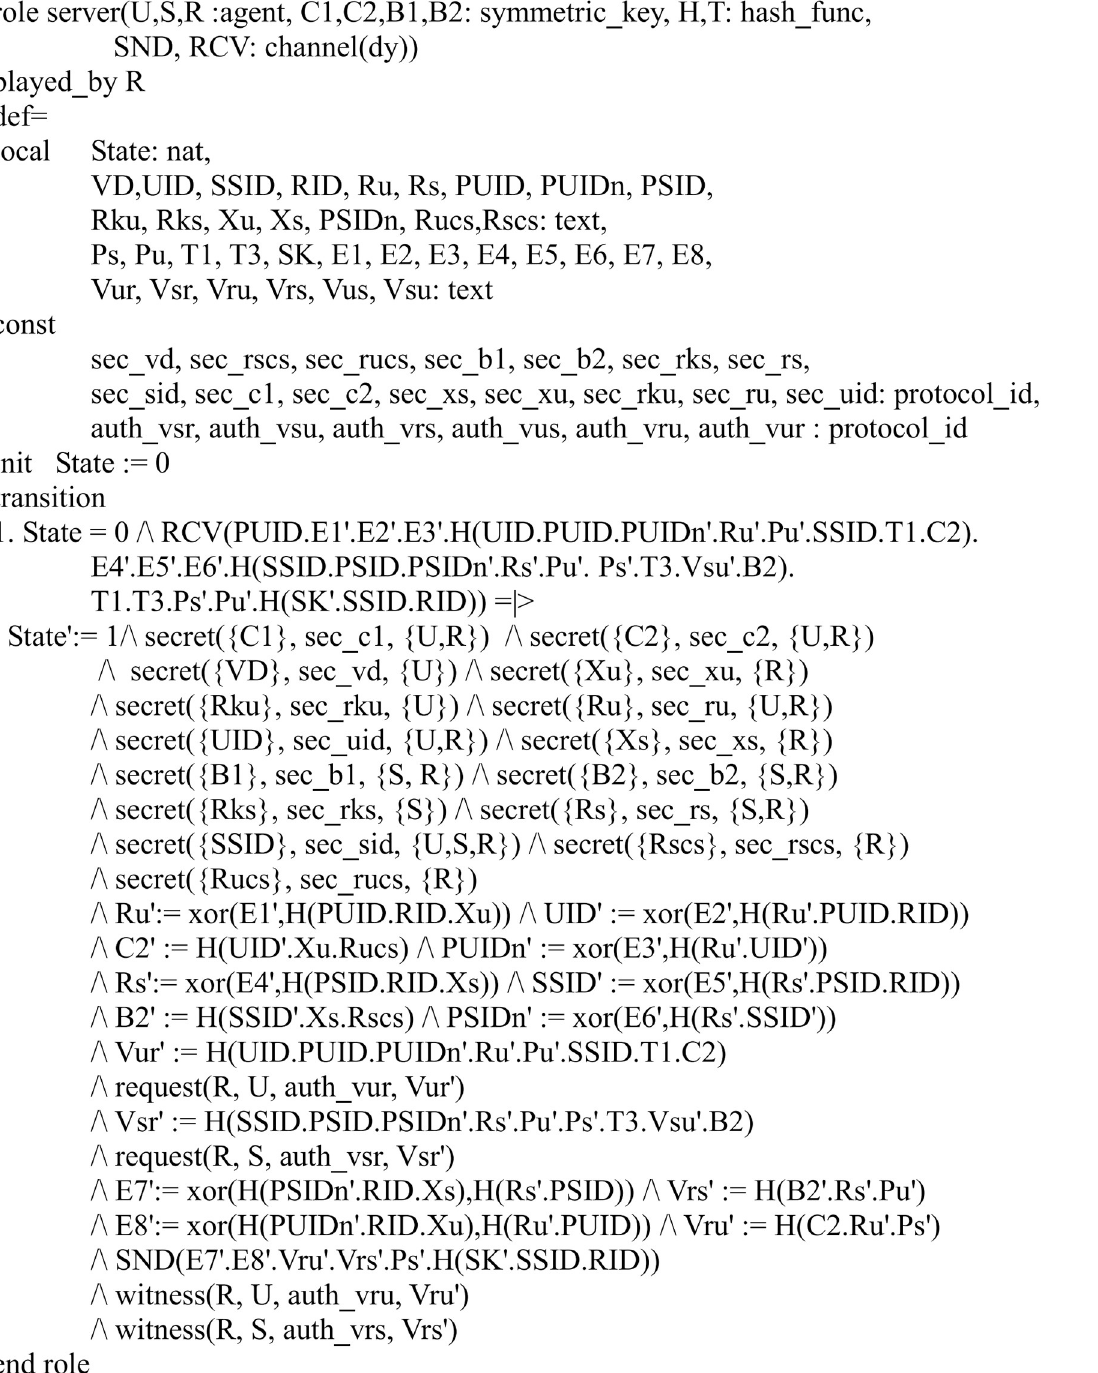
Fig 6. Role specification in HLPSL for the registration center R